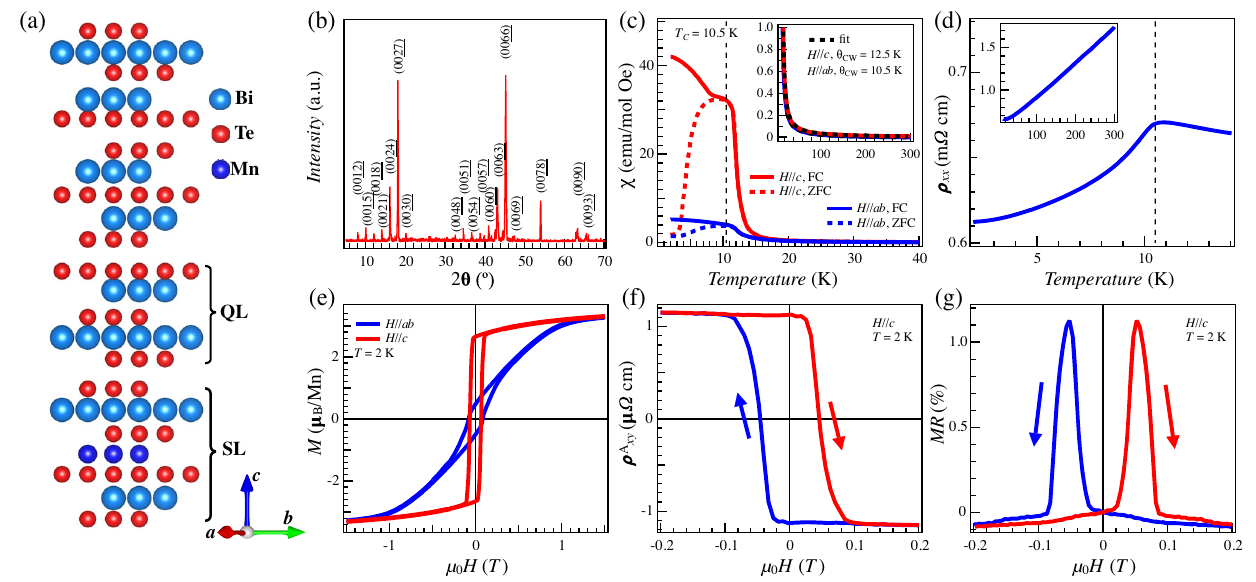
FIG. 1. Ferromagnetism and anomalous Hall effect in MnBi 8 Te 13 single crystals. (a) Schematic crystal structure with one unit of -SL-QL-QL-QL- sequences. (b) Single-crystal x-ray diffraction result taken at 300 K. (c) Zero-field-cooled (ZFC, dashed line) and field-cooled (FC, solid line) magnetic susceptibility ( χ ) vs temperature ( T ) for magnetic field H ¼ 100 Oe parallel to the ab plane (blue) and the c axis (red), respectively. The inset shows the Curie-Weiss fitting for a temperature range of 150 K – 300 K. (d) Zero-field in- plane resistivity ( ρ ) vs T . The inset shows the results up to 300 K. (e) Field-dependent magnetization hysteresis at 2 K for H==ab (blue) xx and H==c (red). (f) Field-dependent anomalous Hall resistivity ( ρ A xy ) at 2 K for H==c . (g) Field-dependent transverse resistivity